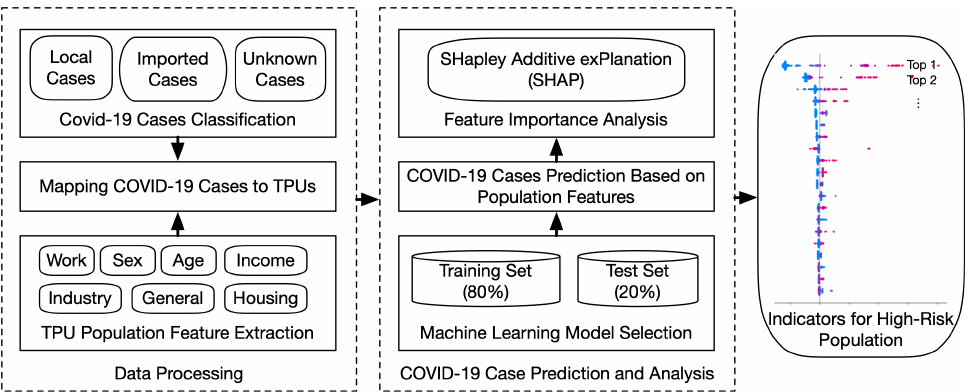
Figure 1. The pipeline of identifying indicators for high-risk COVID-19 transmission